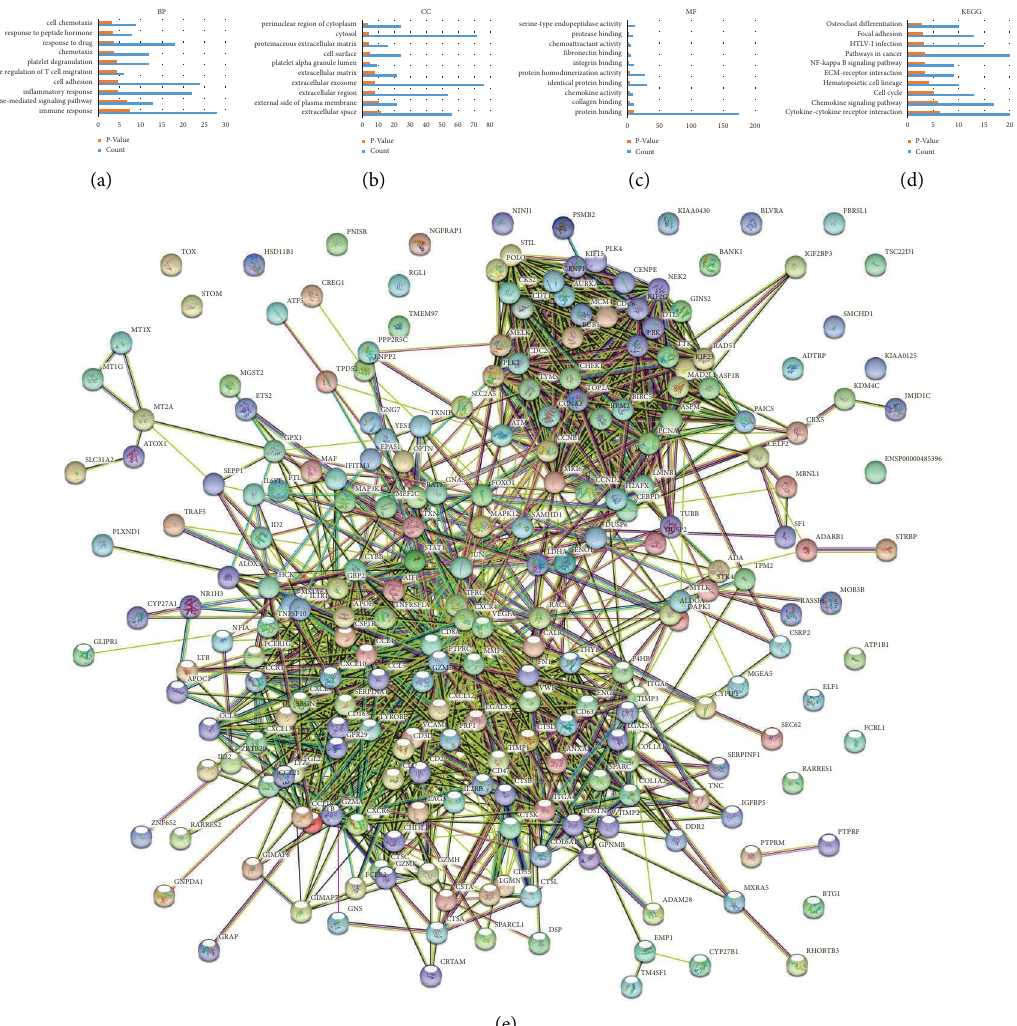
Figure 2: GO, KEGG, and PPI analyses of 243 DEGs. (a-c) GO functional enrichment analysis (top 10), including BP, CC, and MF. (d) KEGG pathway enrichment analysis (top 10). (e) PPI network of